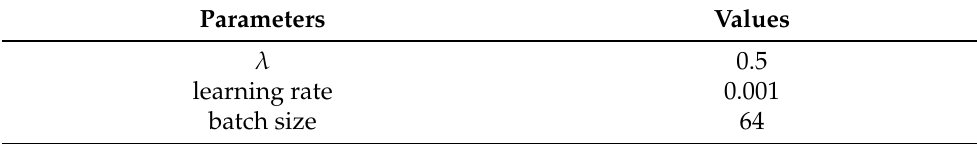
Table 2. The settings of experiment